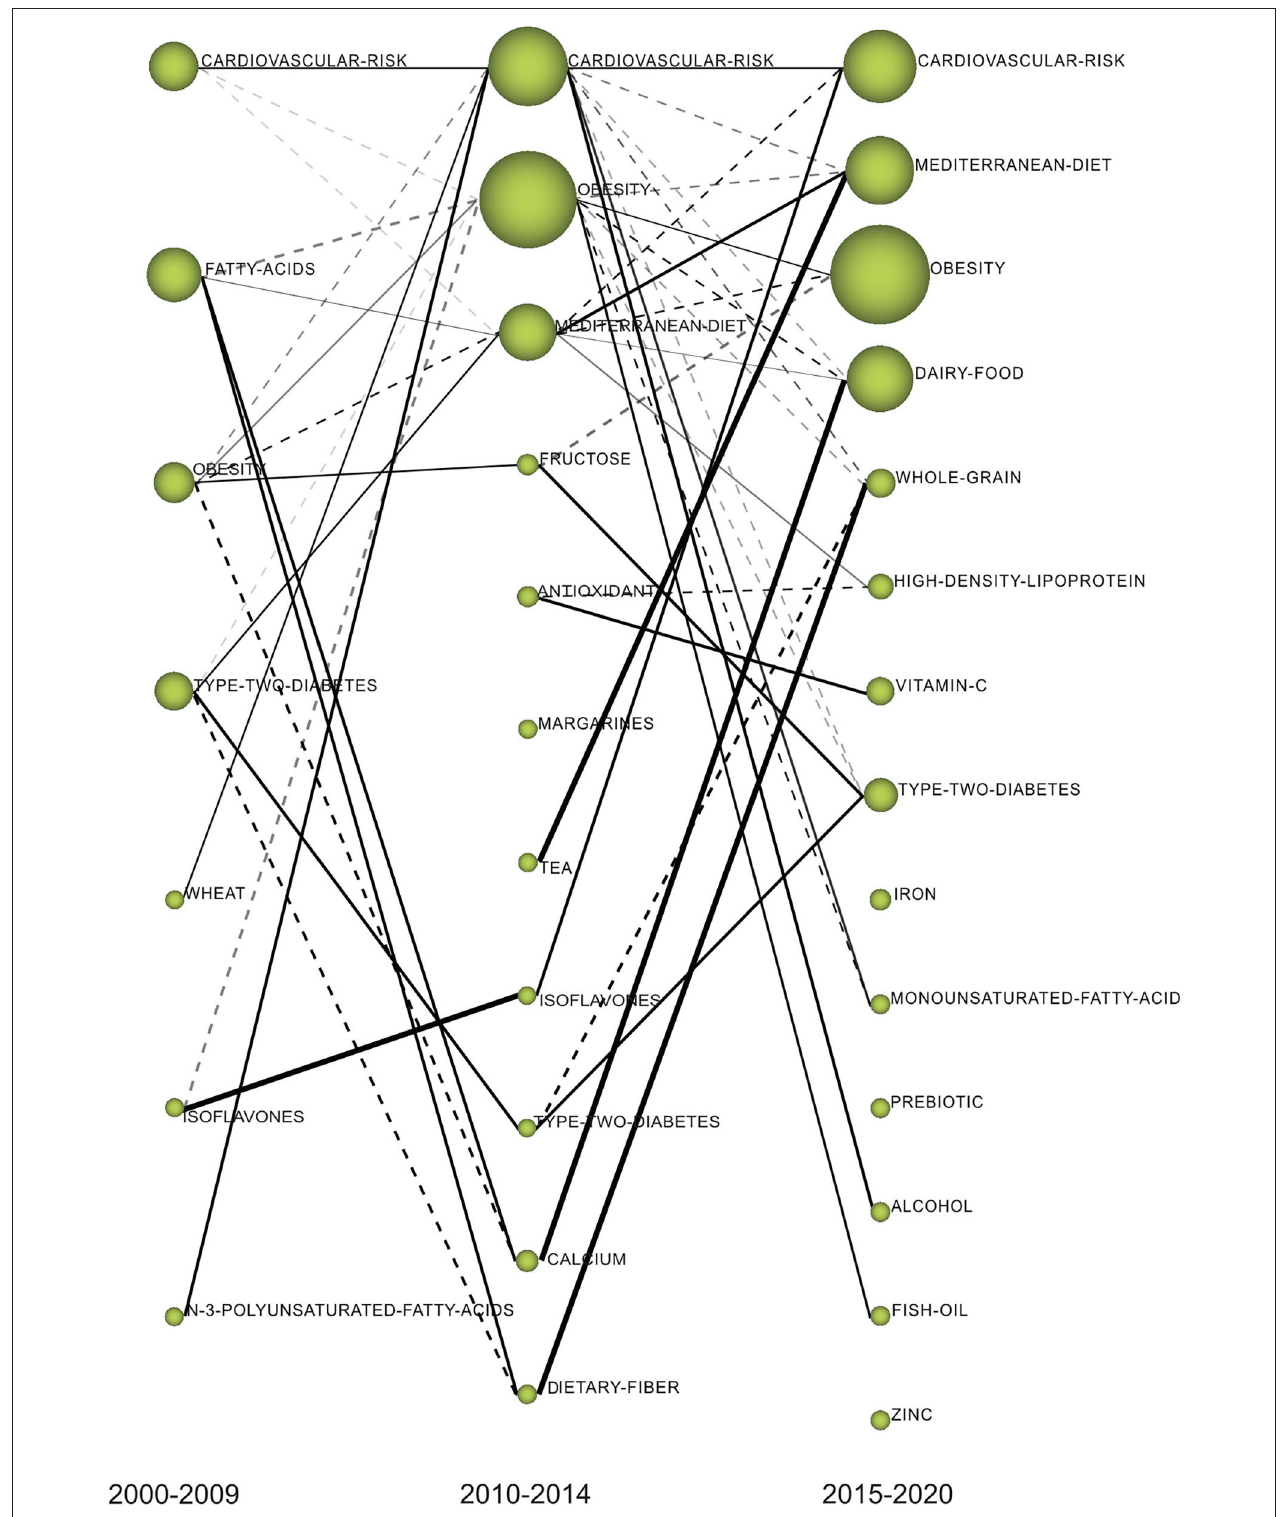
FIGURE 8 | The thematic evolution map of dietary factors of MetS.